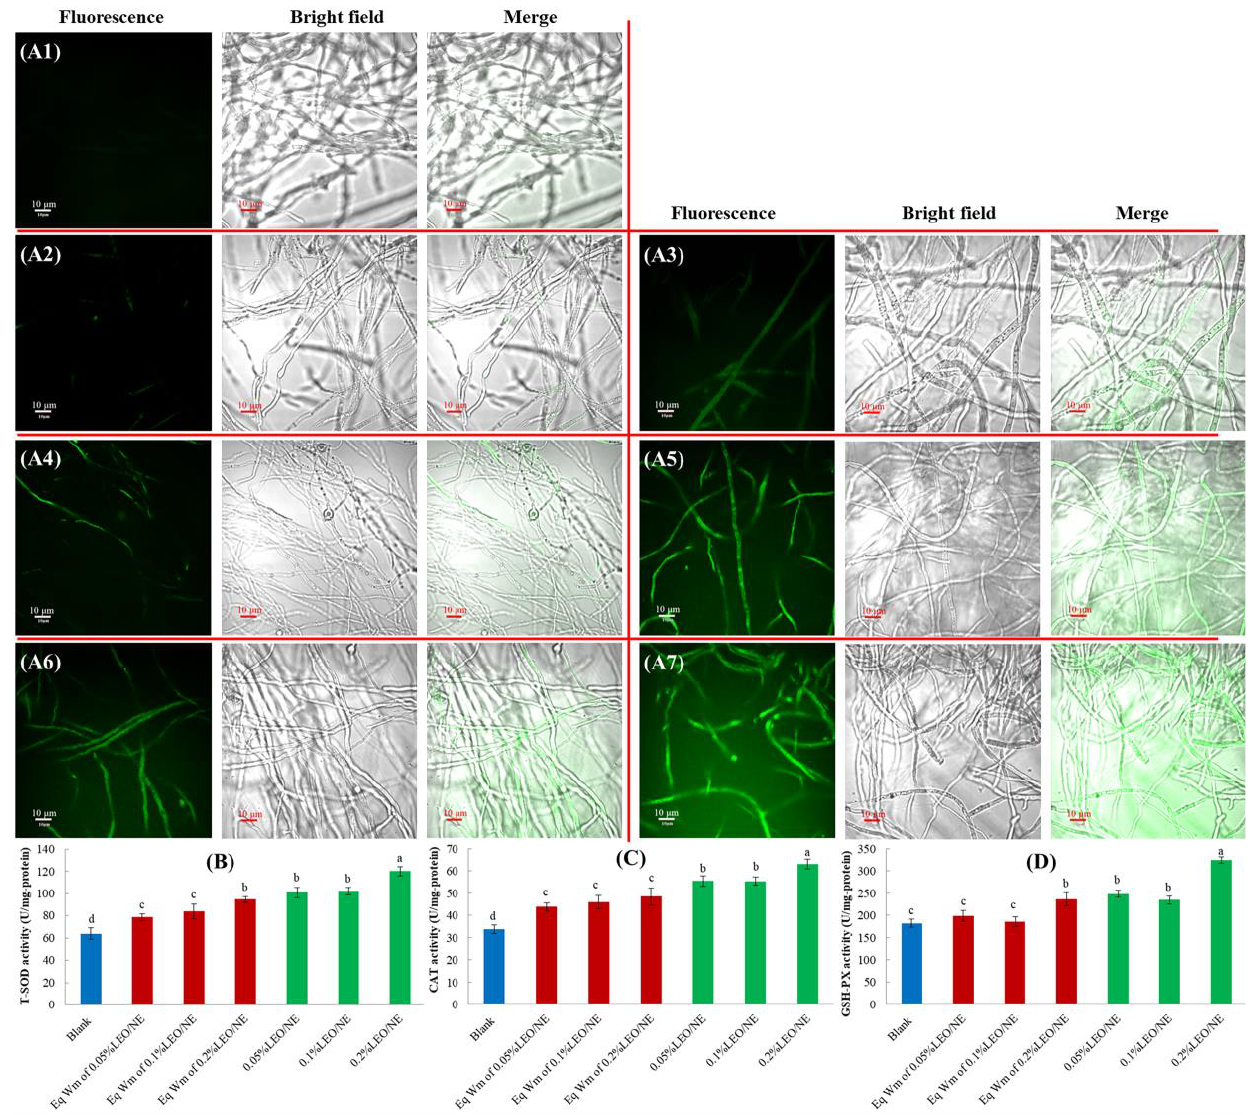
Figure 4. Effects of lemon essential oil nanoemulsion (LEO/NE) and equivalent wall material (Eq Wm) on reactive oxygen species (ROS) accumulation and intracellular antioxidant enzyme activities of Phomopsis sp. ( A1 ), ( A2 ), ( A3 ), ( A4 ), ( A5 ), ( A6 ) and ( A7 ) was the DCFH − DA staining results of Blank, Eq Wm of 0.05%LEO/NE, Eq Wm of 0.1%LEO/NE, Eq Wm of 0.2%LEO/NE, 0.05%LEO/NE, 0.1%LEO/NE and 0.2%LEO/NE, respectively; ( B ) CAT activities; ( C ) SOD activities; ( D ) GSH − PX activities. Different letters above each column of (B), (C) and (D) indicate significant differences.